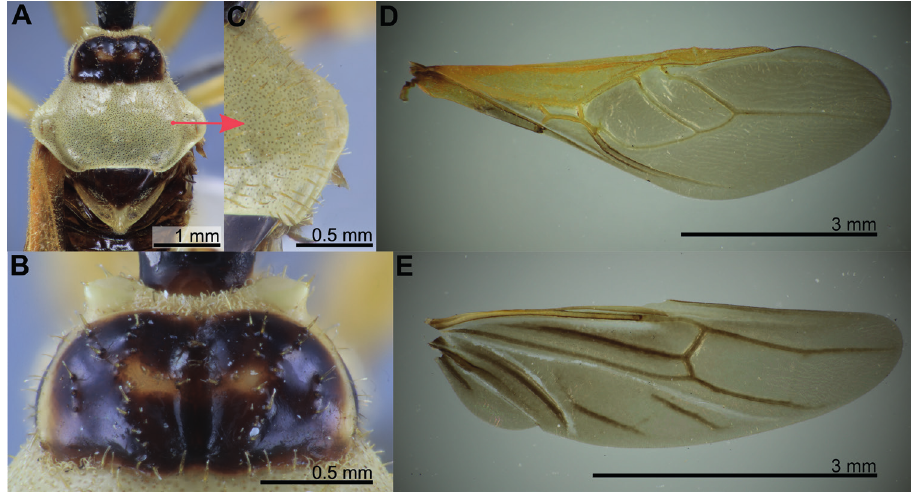
Figure 20. Biasticus luteicollis Ha, Truong & Ishikawa, sp. nov., holotype, ♂ , HNL2018-025 A pronotum in dorsal view B anterior pronotal lobe in dorsal view C setae on posterior pronotum D right hemelytron E right hind